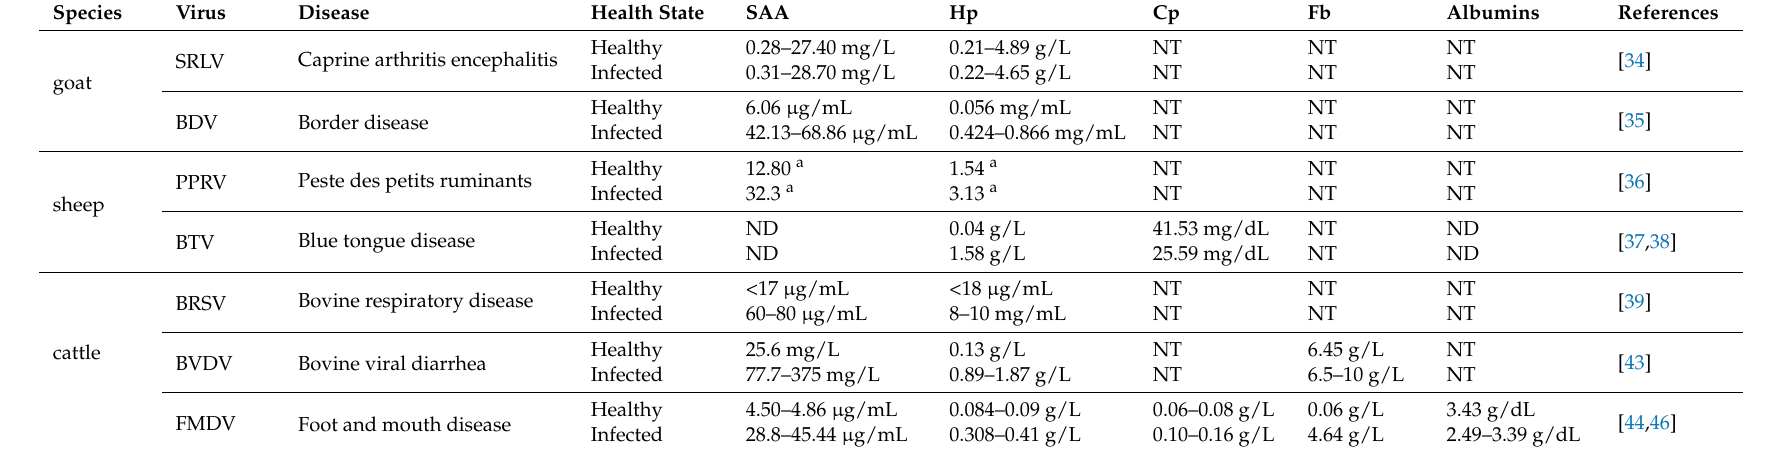
Table 2. The concentrations of acute phase proteins in healthy and virus-infected dairy